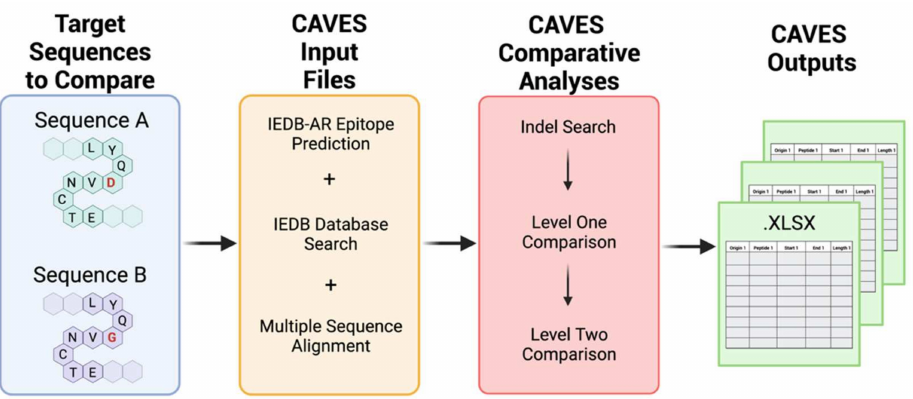
Figure 1. CAVES user workflow. CAVES performs comparative analyses between epitopes from two closely related sequences (sequences A and B). Target sequences are used to generate epitope predictions and database search results from the Immune Epitope Database (IEDB) resources and for multiple sequence alignment. The resulting files are input directly into the CAVES user interface for multi-level comparisons, and CAVES sorted results are output in xlsx